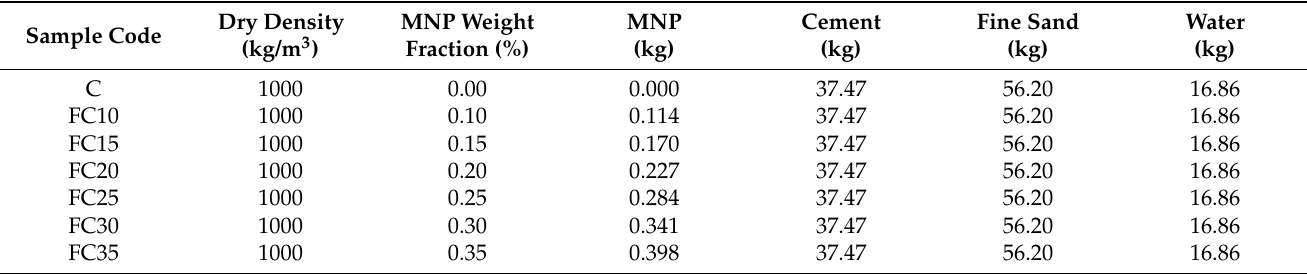
Table 4. FTIR peaks of MNP. Table 5. LFC mix